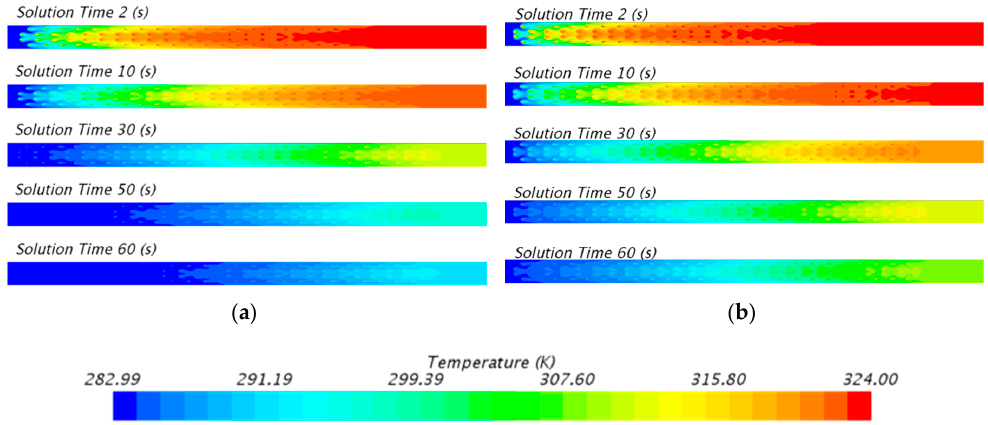
Figure 11. The comparison of temperature scale with different porosities at different times in the oblique section: ( a ) Porosity of 0.85, ( b ) porosity of 0.75.